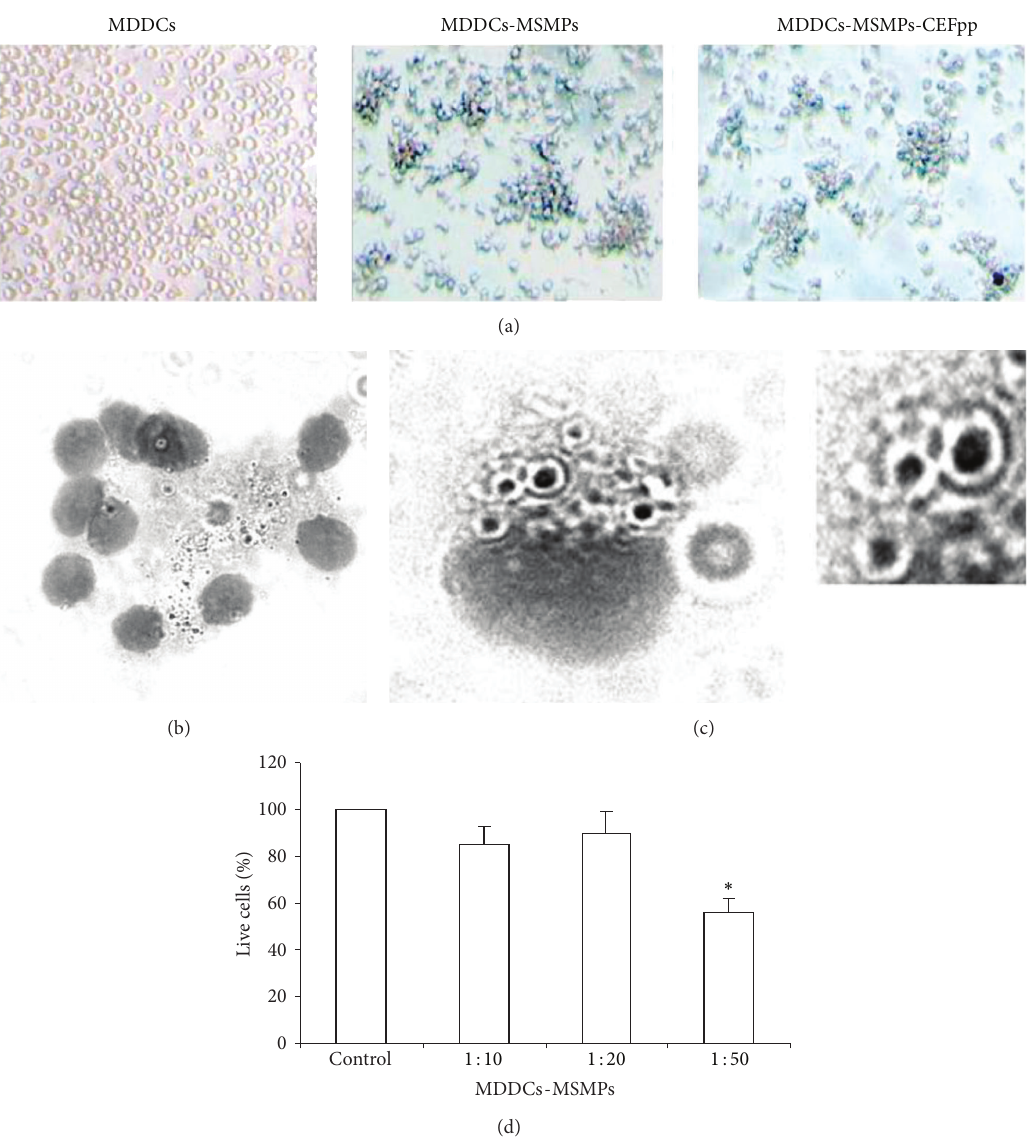
Figure 3: The microparticles are internalized into dendritic cells (DC). (a) Photographs show control cells (MDDCs) or with internalized unloaded (MDDCs-MSMPs) or peptide loaded (MDDCs-MSMPs-CEFpp) microparticles. After 24h of incubation the cells are aggregated, and the particles are inside vacuoles ((b)-(c) and insert). Trypan blue dye was used to determine the percentage of live MDDCs relative to a nontreatment control following 24 h incubation with MSMPs (d). ∗ 𝑃 < 0.05